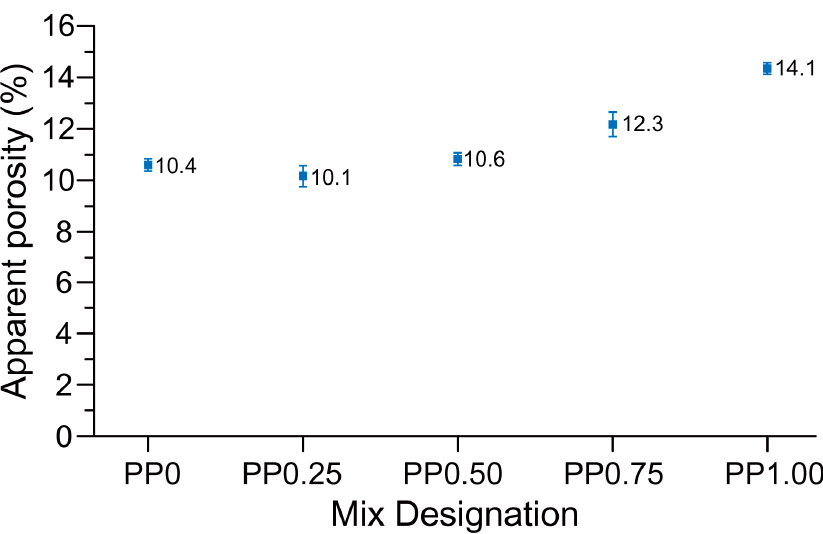
Figure 8. The porosity of printed fibre-reinforced specimens.